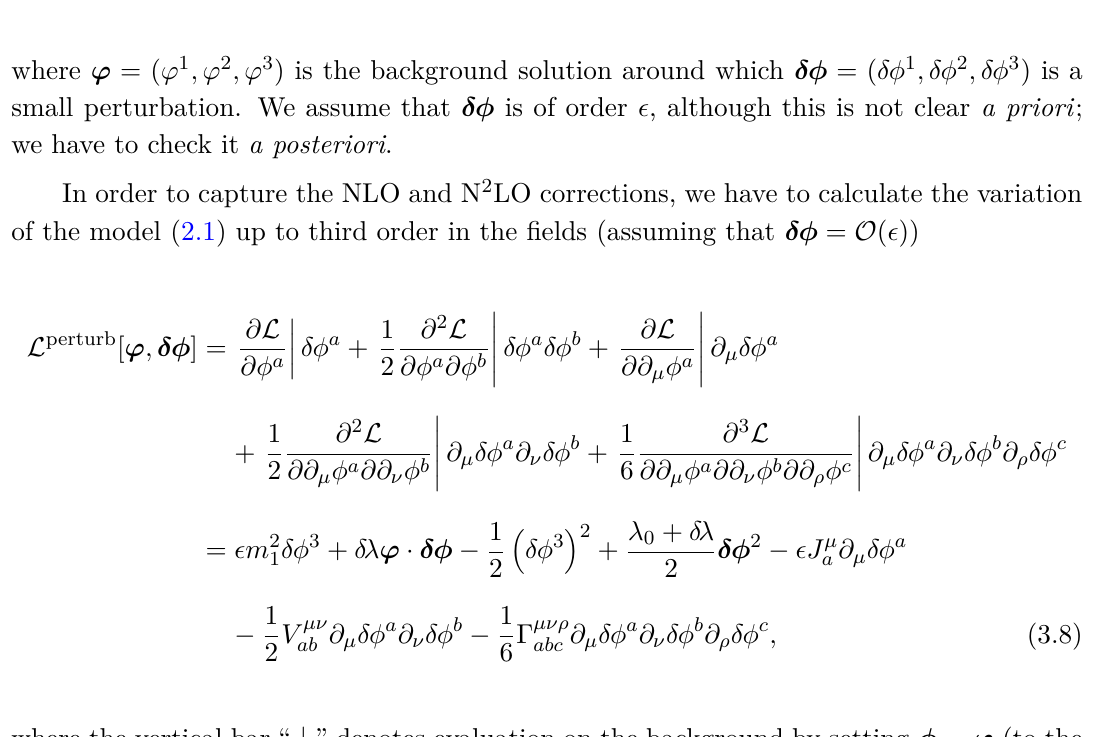
Figure 1. Leading-order energy per nucleon (baby Skyrmion) divided by (cid:15) : M LO N for m 1 = 0 , 0 . 5 , 1 (from bottom to